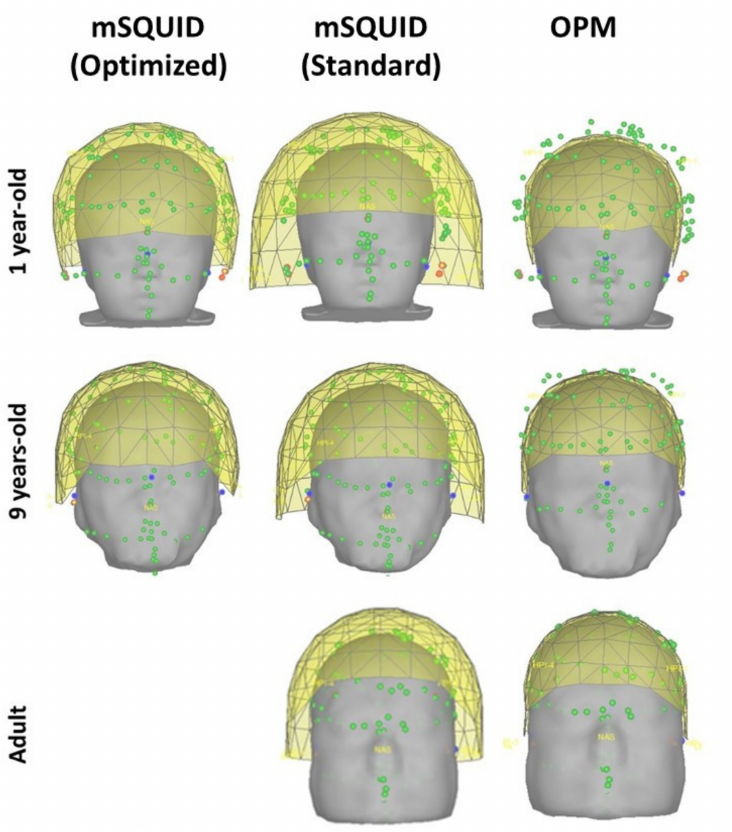
Figure 1. The frontal views of the mSQUID (Optimized) ( left ), mSQUID (Standard) ( middle ) and OPM ( right ) sensors helmet for three different subjects (a 1-year-old, a 9-year-old, and an